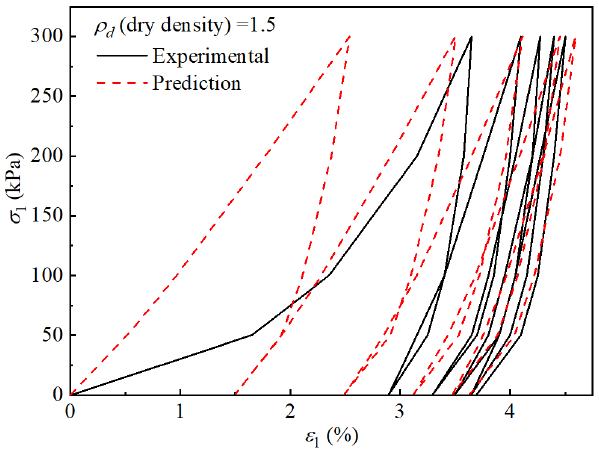
Figure 9. Comparison of prediction with experimental results of silica sand in a cyclic oedometric compression test. Table 3. Parameters for empirical formulations in